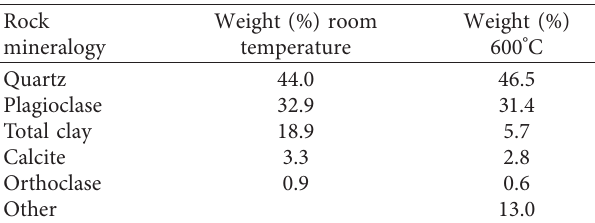
Figure 7: Results of X-ray diffraction and mineral composition (Q: quartz, K: kaolinite; the blue line is at room temperature; the red line is after treatment at 600 ° C). Table 2: XRD analysis